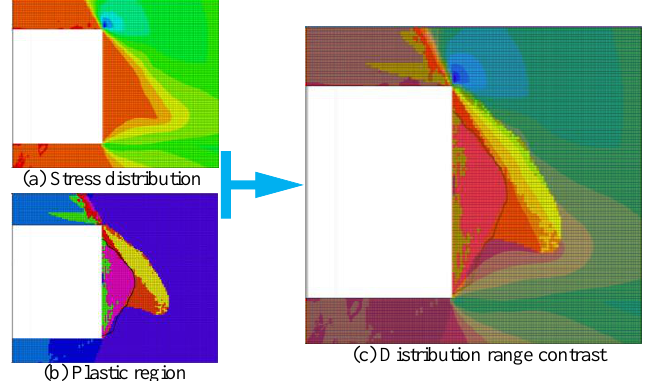
Figure 10. Comparison of the ranges of plastic and stress zones in the coal wall.